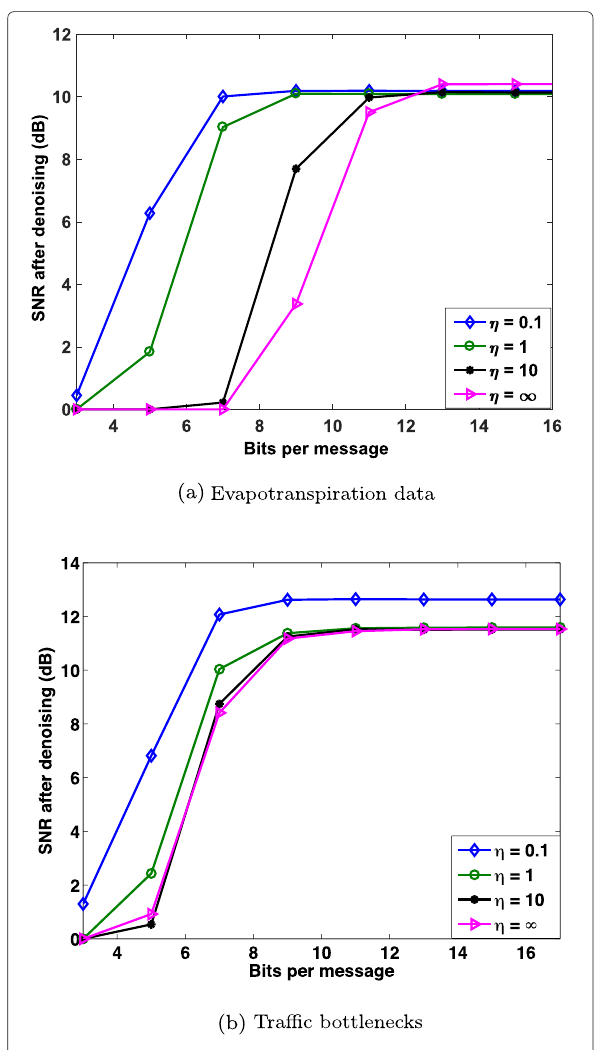
Fig. 7 Denoising performance (in dB) versus bit rate per message for l 1 regularization using dictionaries learned with different values of η . The SNR of the noisy signals is 10 dB. ( a ) Evapotranspiration data ( b ) Traffic